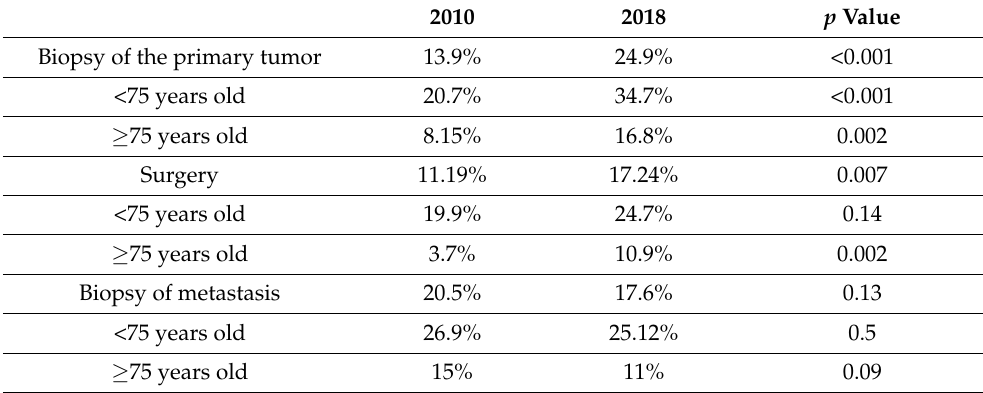
Table 2. Type of microscopic diagnosis in PC patients diagnosed in 2010 and in 2018 by age class (percentage expressed on total PC cases of the referral year).